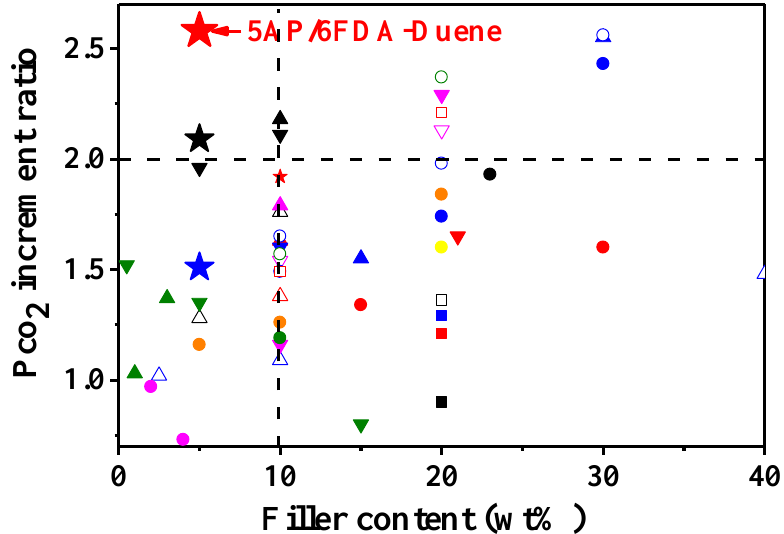
Figure 5. 𝑃 𝐶𝑂 increment ratio of PI based MMMs with MOPs or MOFs loading compared to pris- Figure 5. P CO increment ratio of PI based MMMs with MOPs or MOFs loading compared to pristine 2 2 tine PI membrane. ( ★ ), ( ★ ), and ( ★ ) are 6FDA-Durene with 5% of AP, BP, and TP loading (this PI membrane. ( (cid:70) ), ( (cid:70) ), and ( (cid:70) ) are 6FDA-Durene with 5% of AP, BP, and TP loading (this work), work), respectively. Triangles are 6FDA-Durene with NH 2 -MIL-101 ( ▲ ) [45] , CNT-MIL ( △ ) [45] , respectively. Triangles are 6FDA-Durene with NH 2 -MIL-101 ( (cid:78) ) [45], CNT-MIL ( (cid:52) ) [45],